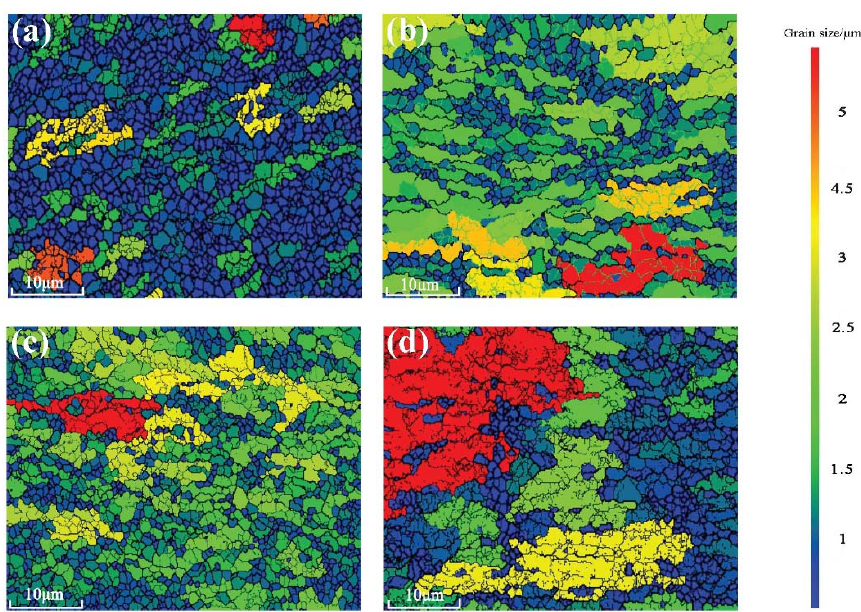
Figure 3. The EBSD microstructure of aluminum alloy processed by different routes of CECC. ( a ) MEM; ( b ) MEE; ( c ) 3-pass of ECAP; ( d ) 3-pass of MAC.